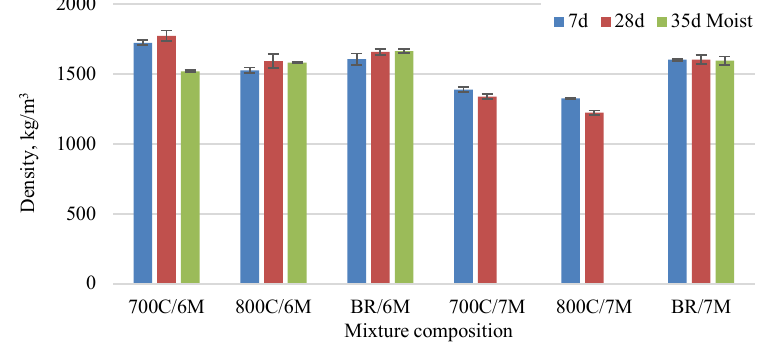
Fig. 7. Density of AAM with red clay precursors.